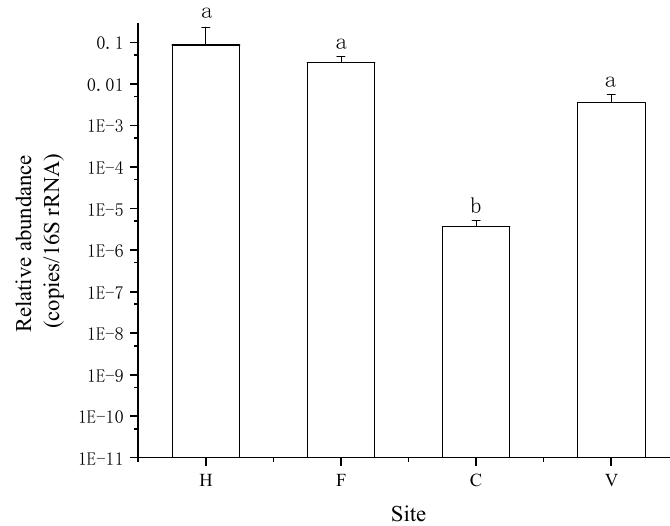
Figure 2. The relative copy number (copies/16S rRNA, relative abundance) of ARGs. H: hospital; F: farm; C: city residence; V: village residence. Error bars indicate standard errors of three replicates, different lowercase letters indicate a significant difference ( p < 0.05).